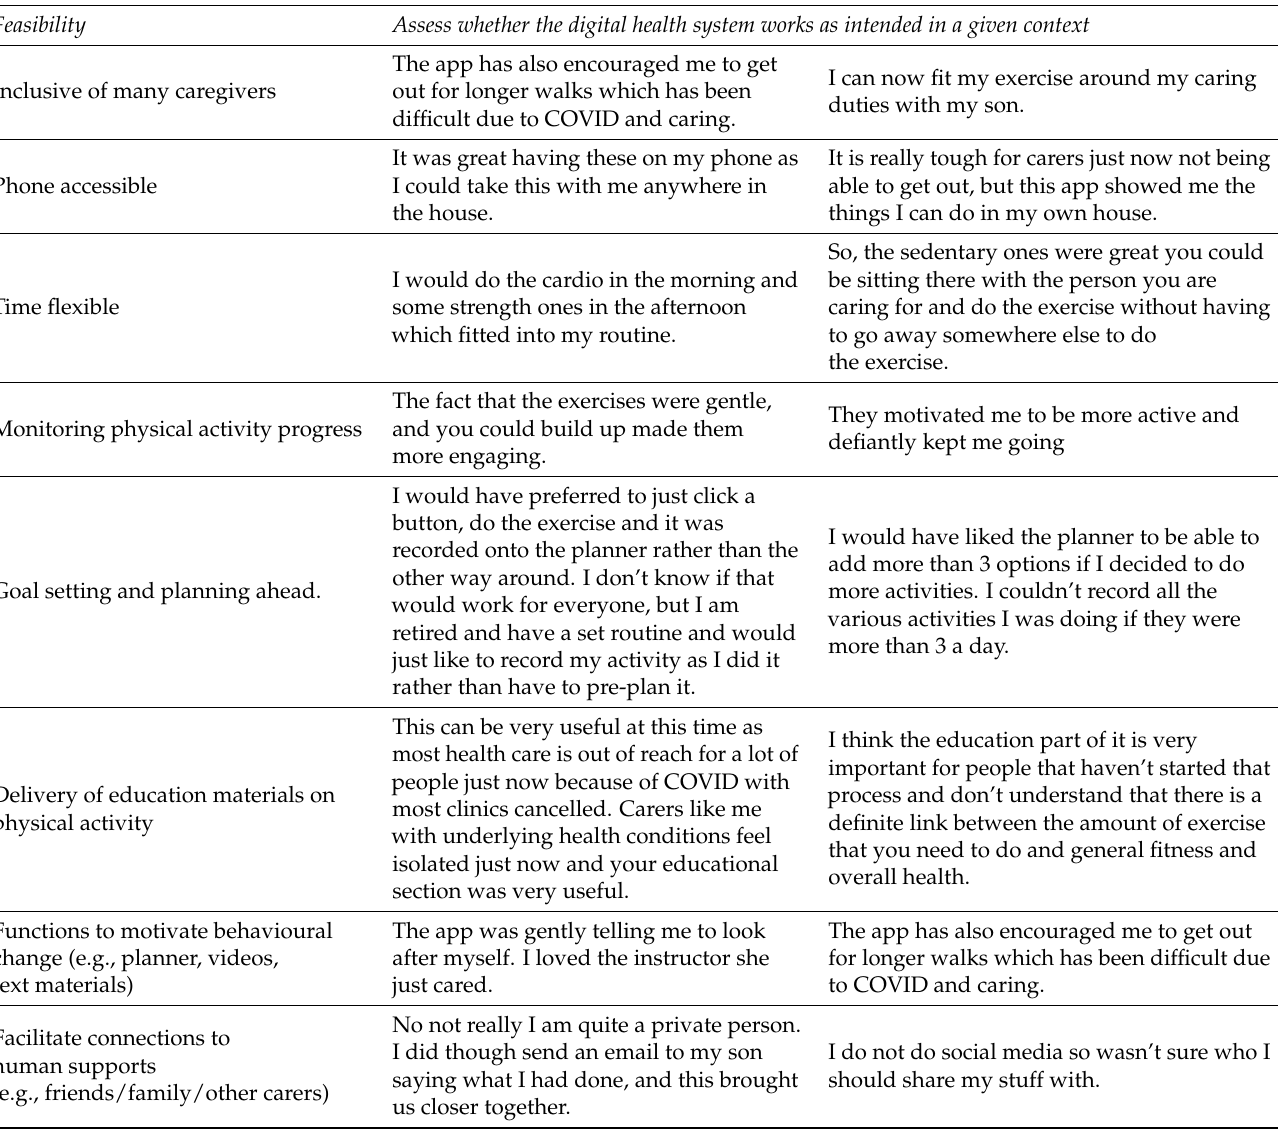
Table A1. Qualitative feedback of the needs of participants around feasibility, accessibility and usability of